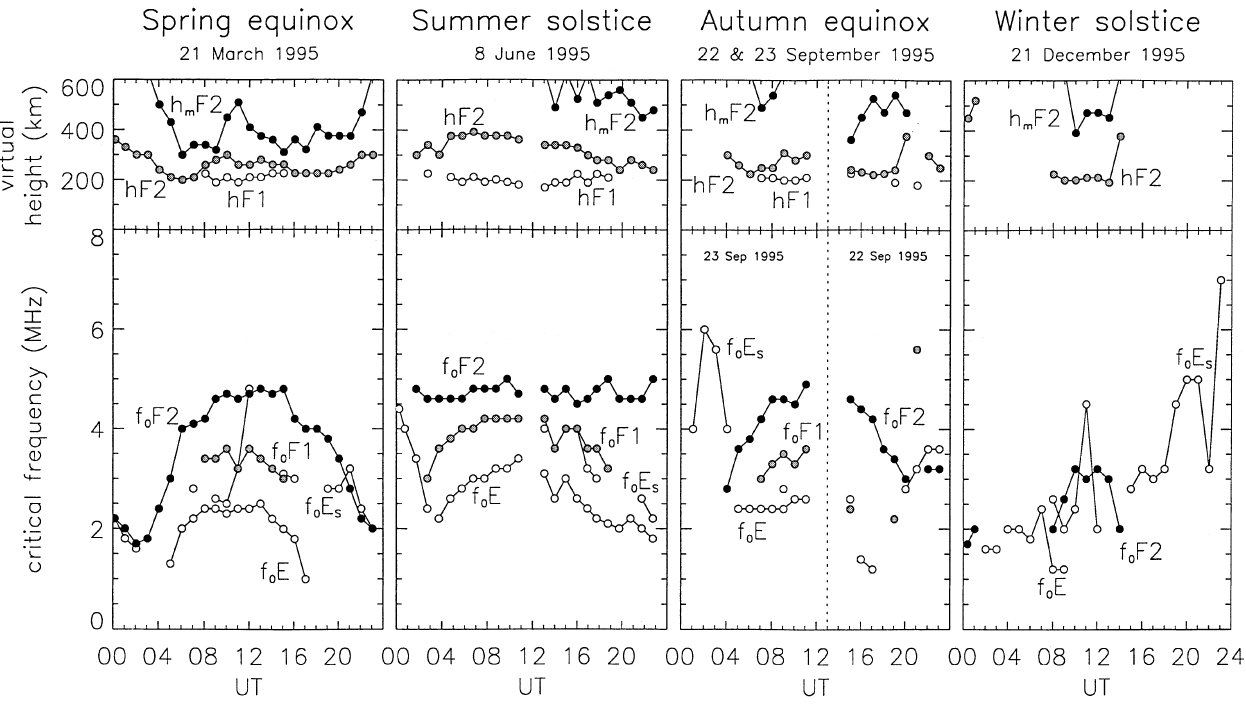
Fig. 5. Ionospheric parameters measured by the Tromsø dynasonde for four days near the solstices and equinoxes of